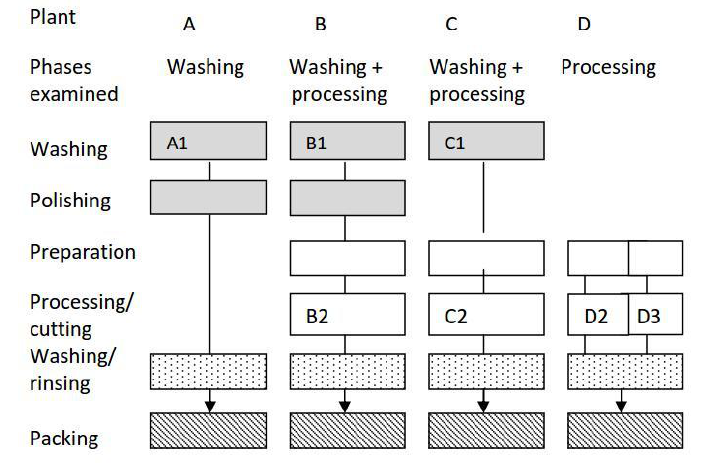
Fig. 1. Phases of the processes in the four vegetable processing plants examined. In plant A the washing phase (A1), in plants B and C the washing (B1, C1) and processing phases (B2, C2), and in plant D the phases of carrot (D2) and lettuce (D3) processing were